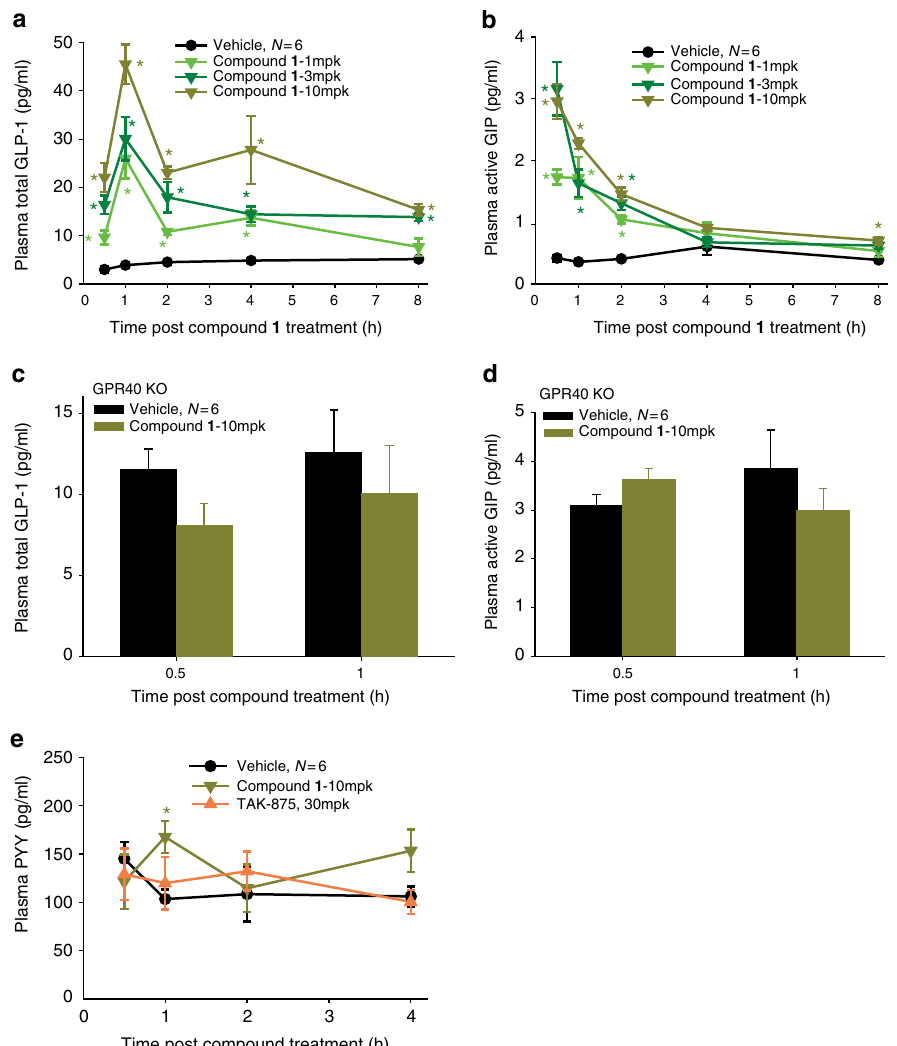
Fig. 3 GLP-1 and GIP secretion by compound 1 . a compound 1 signi fi cantly increases plasma total GLP-1 concentrations up to 8 h. b compound 1 signi fi cantly increases plasma active GIP concentrations up to 8 h. c , d compound 1 has no effect on plasma total GLP-1 ( c ) and active GIP ( d ) concentrations in GPR40 KO mice. e Both compound 1 and TAK-875 exert no effect on plasma PYY level. Incretin values were log2 transformed and analyzed using ANOVA. * p < 0.05 vs vehicle by ANOVA with repeated measures followed by Dunnett ’ s